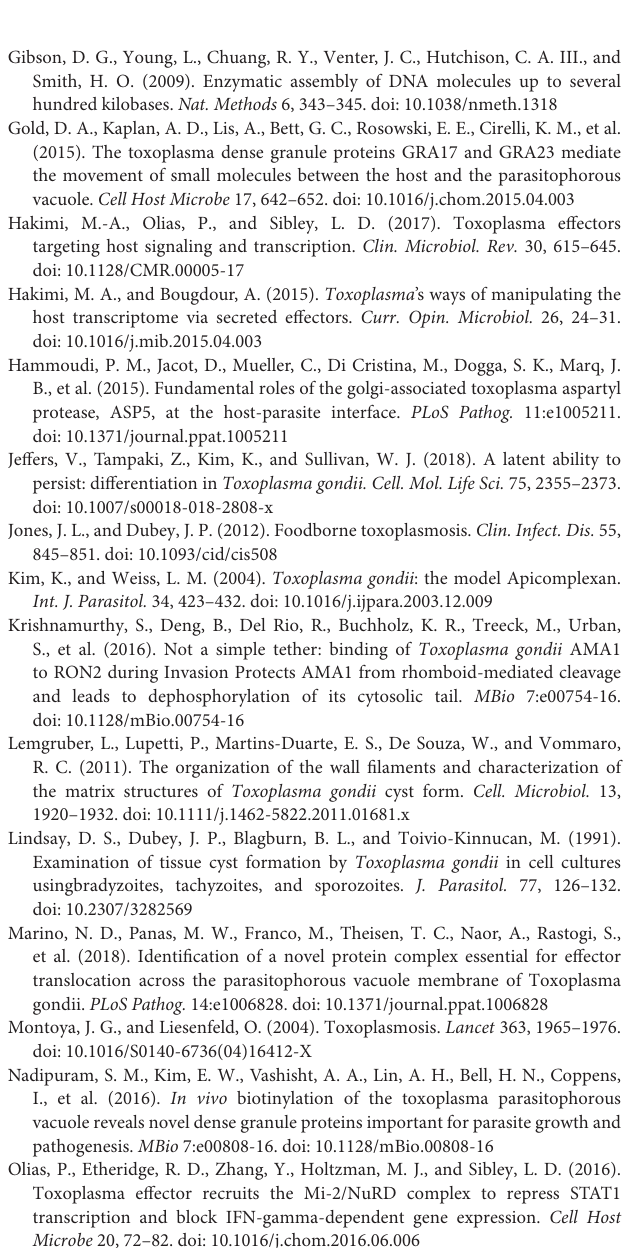
Supplemental Figure 1 | Localization of GRA16-HA and GRA24-HA to the host cell nucleus was observed only in multiple infected host cells containing parasites in different stages of in vitro stage conversion. Parasites expressing GRA16-HA (A) or GRA24-HA (B) localized the respective epitope tagged GRAs in the parasites as well as in the host cell nucleus. Non-uniform DBA staining suggests that the parasites were in different stages of conversion into tissue cysts. Images are scaled to 10 µ